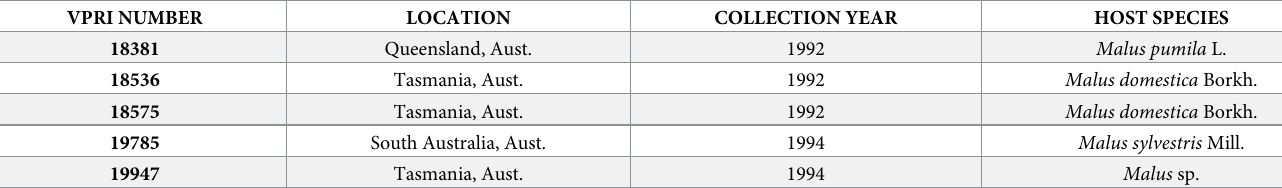
Table 1. Victorian plant pathology herbarium (VPRI) P . leucotricha specimens